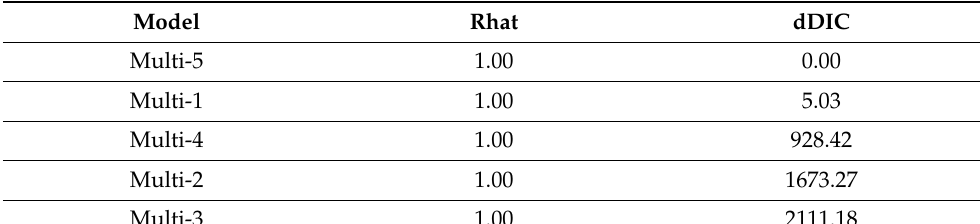
Table 2. Comparison of how models fit to the data when using the multinomial distribution. Rhat indicates the conversion of Markov chain Monte Carlo, where Rhat < 1.1 is considered to be acceptable. Figure 6. Sightings per Station by Month, 2013–2021. dDIC indicates the difference in deviance information criteria (DIC) value from the smallest DIC value, where the model with the smallest DIC is considered best.